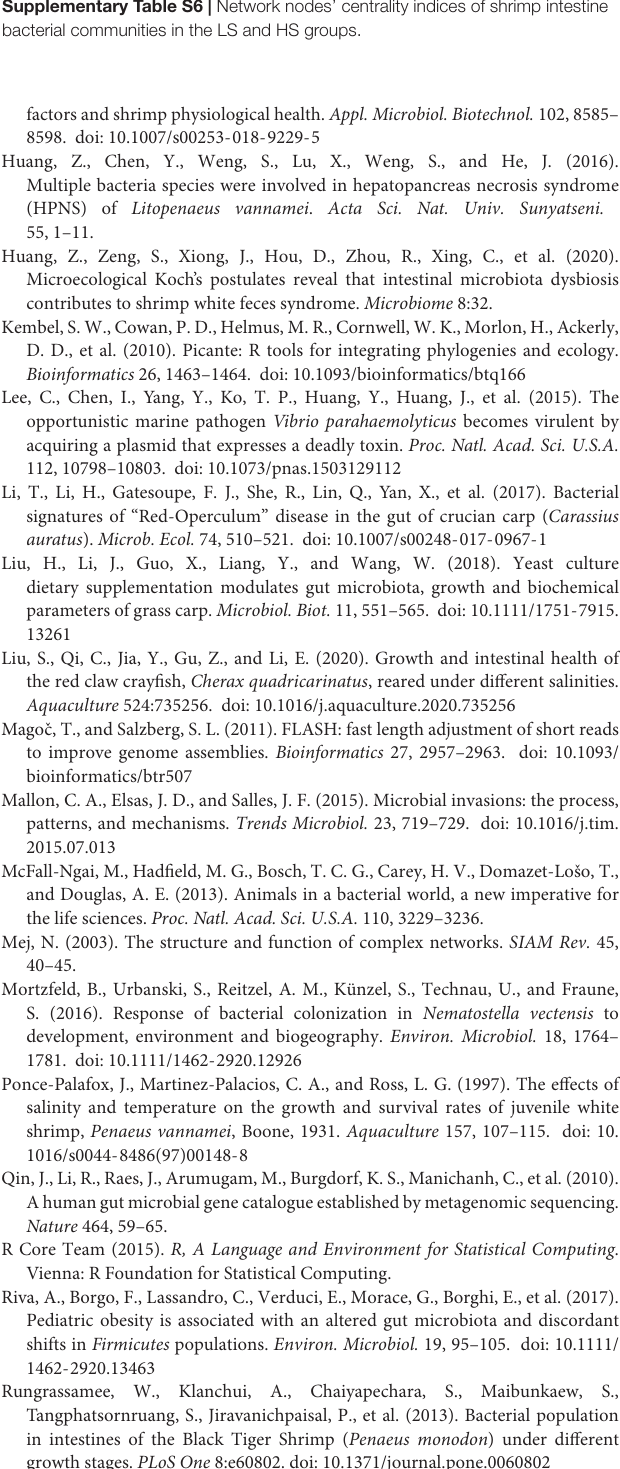
And the highlighted in gray indicates that the species are opportunistic pathogens in shrimp